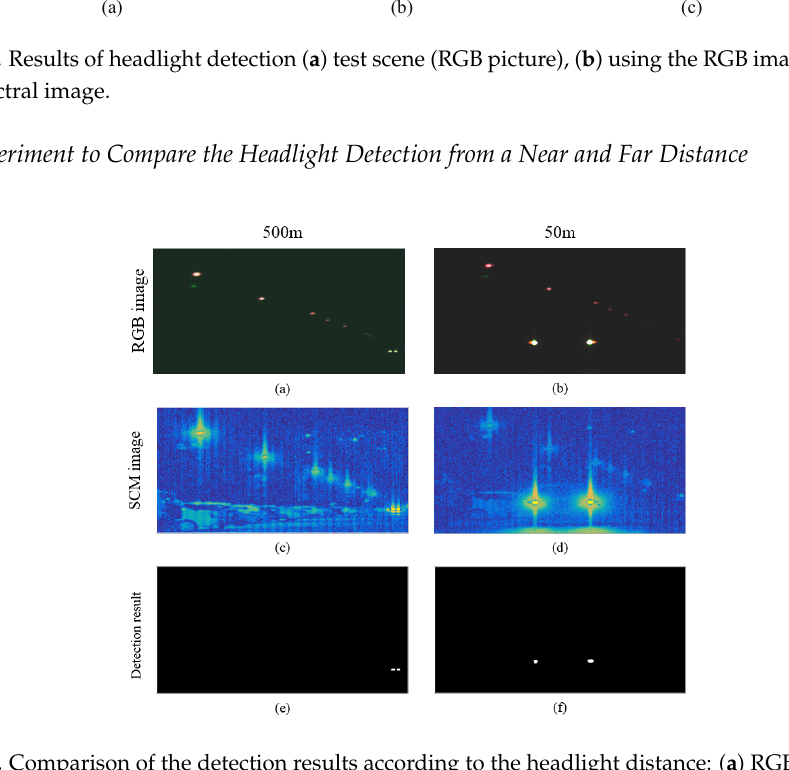
Figure 16. Comparison of the detection results according to the headlight distance: ( a ) RGB composite image acquired at 500 m; ( b ) RGB composite image acquired at 50 m; ( c ) SCM result for the hyperspectral image at 500 m; ( d ) SCM result for the hyperspectral image at 50 m; ( e ) detection result by thresholding to the SAM image for the 500 m data; ( f ) detection result by thresholding to SAM image for the 50 m